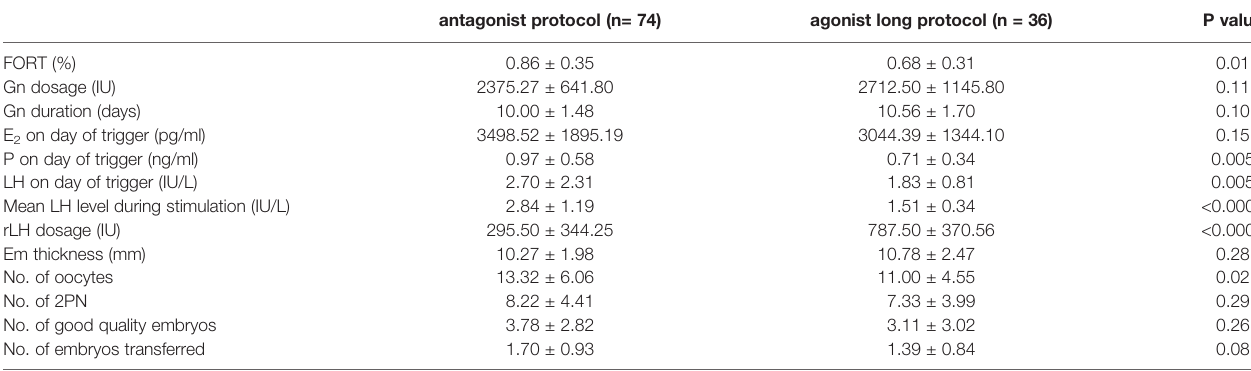
TABLE 2 | Cycle parameters in antagonist vs. agonist long protocol group.